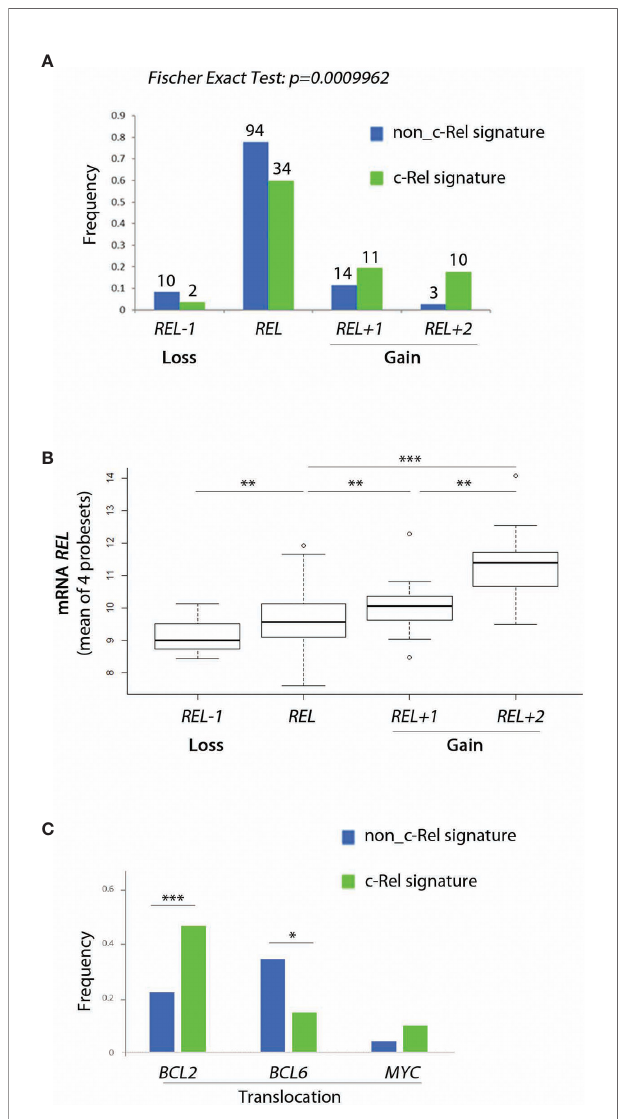
FIGURE 4 | Relationship between c-Rel signature, REL gain, REL mRNA expression and BCL2 , BCL6 and MYC translocations for patients from the GHEDI cohort. (A) Frequency of REL deletion or gain according to c-Rel signature. (B) REL mRNA expression levels according to REL loss or gains. (C) Frequency of BCL2 , BCL6 , and MYC translocations according to the c-Rel signature. In Figures 3A, C , green and blue bars indicate tumors respectively expressing or not the c-Rel signature. In Figures 3A, B , REL deletion, no REL number aberrancy, gain of one REL copy, and of two or more REL copies are encoded by REL − 1 , REL , REL+1 and REL+2 respectively. Statistical signi fi cance was determined by t-test (***p<0.001; **p<0.01;